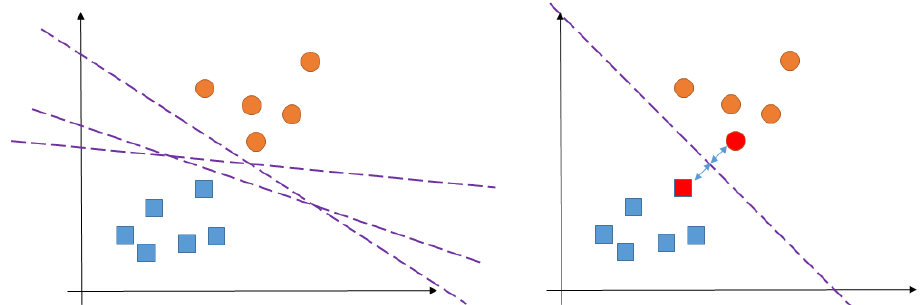
Figure A3. Hyperplanes of a classifier: typical algorithm (left), SMV (right). The decision function of the linear SVM is shown in Equation (A5) below: